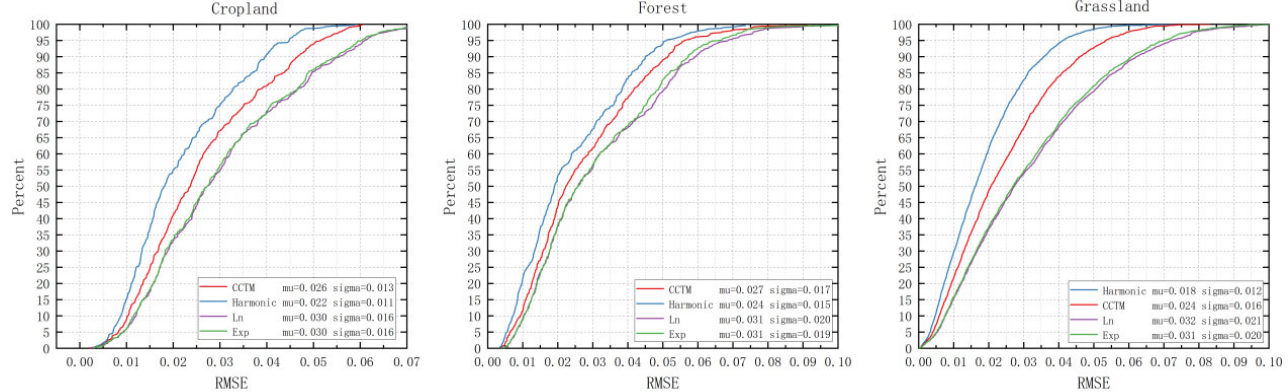
Figure 5. Fitting RMSE distribution on different land cover types among different models. The figs reflect the fitting RMSE probability density distributions of different models. The frequency is the number of time series points in a certain RMSE range, and different land cover types may have different RMSE categories.